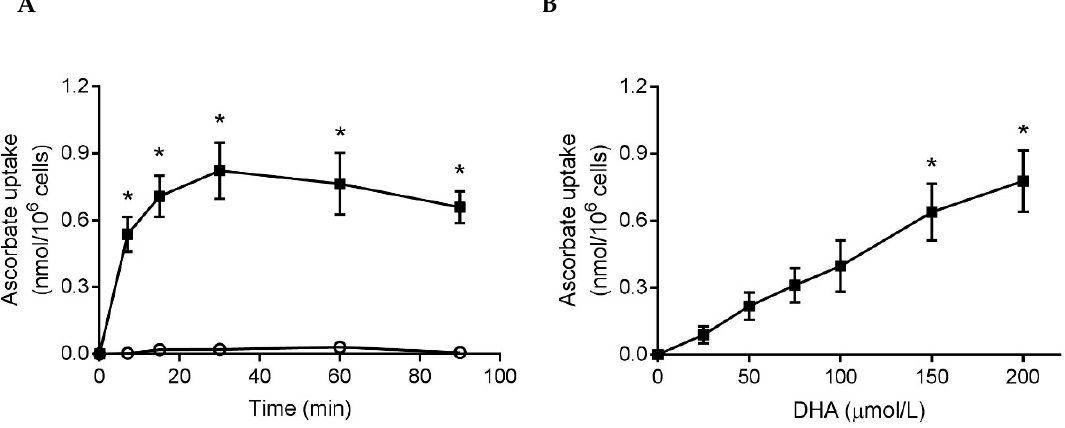
Figure 1. Uptake of ascorbate by neutrophils isolated from healthy individuals. ( A ) Cells were incubated with ascorbate ( ) or DHA ( ), 200 µmol/L, in HBSS for up to 90 min. Intracellular ascorbate was measured by HPLC and expressed as the increase above that of cells processed at 0 min (0.38 ± 0.05 nmol/10 6 cells), n = 3. ( B ) Cells were incubated with increasing concentrations of DHA for